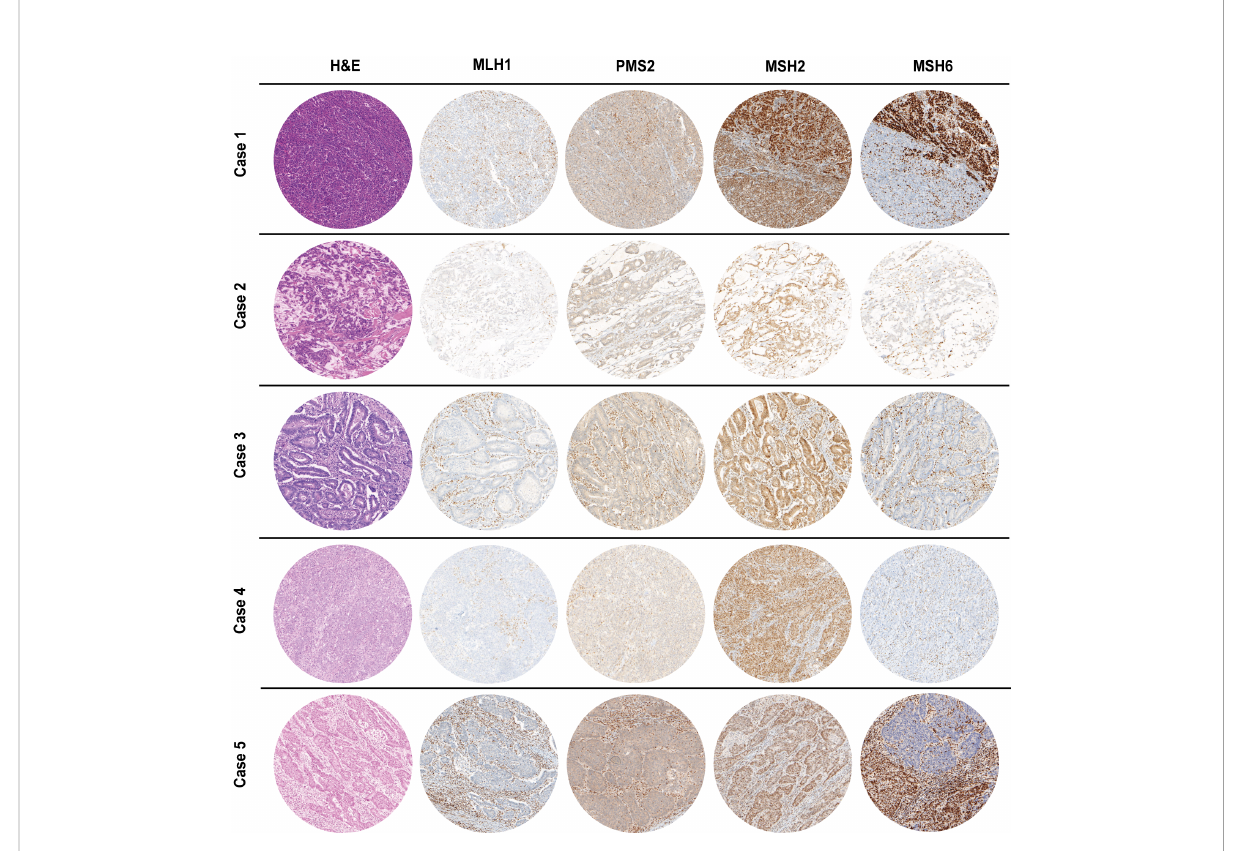
FIGURE 2 H&E as well as MMR IHC of MLH1 - /PMS2 - /MSH6 - cancer cases arising in the digestive tract (100x magni fi cation). Whereas MSH2 staining was preserved, MLH1 & PMS2 were completely absent in all cases. Cases 1&5 presented with a heterogeneous staining pattern for